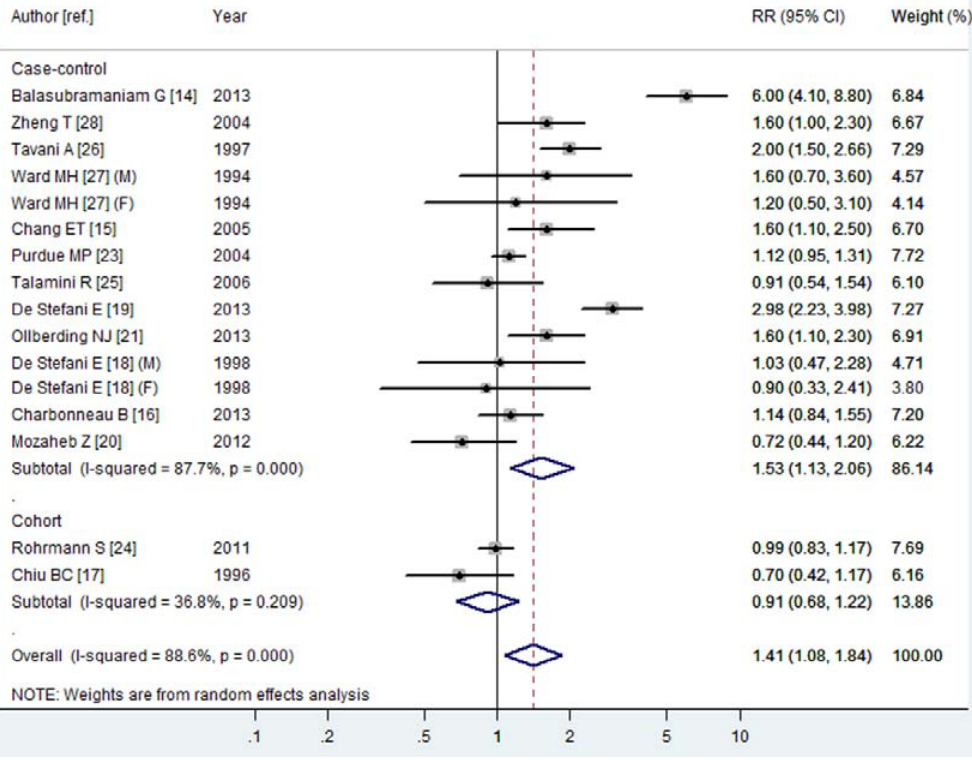
Figure 4. Forest plot of milk consumption and the risk of NHL. The size of the gray box is positively proportional to the weight assigned to each study, and horizontal lines represent the 95% confidence intervals.